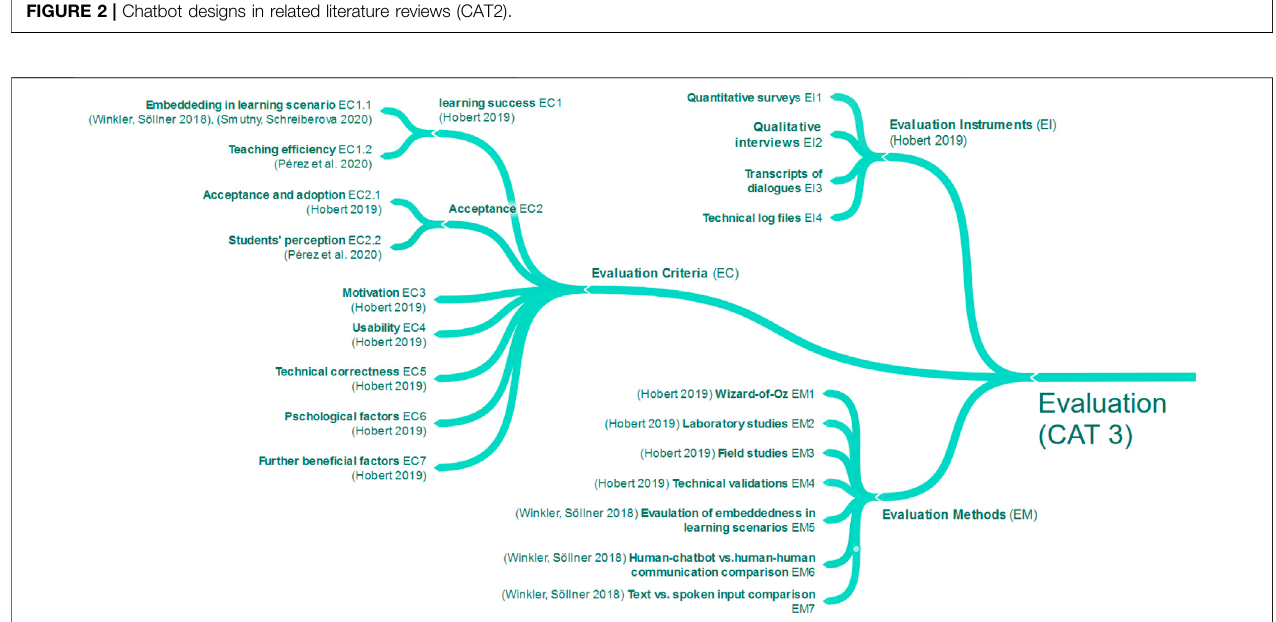
FIGURE 2 | Chatbot designs in related literature reviews (CAT2).